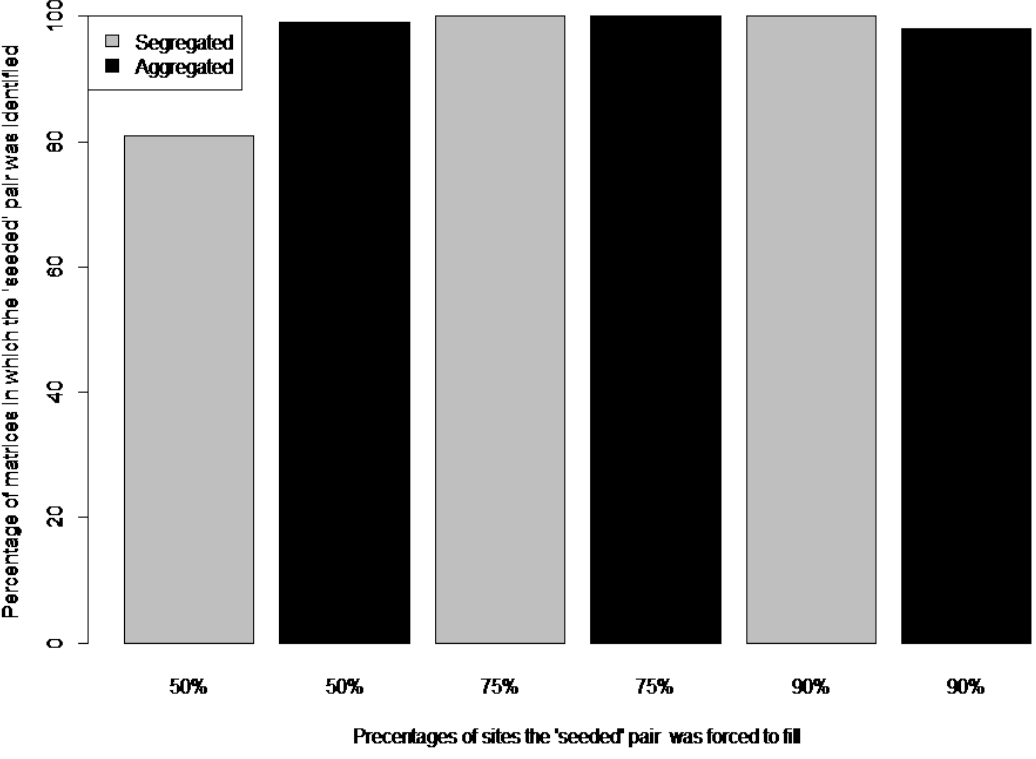
Figure 1. Percentage of matrices in which the ‘seeded’ pair was identified by the ‘natural’ and the pairwise C-score (CS) metrics. Both metrics gave identical percentages. For both segregated (‘checkerboard’ distribution) and aggregated (co-occurring) seeded pairs, the occurrences were forced to fill 50%, 75% and 100% of